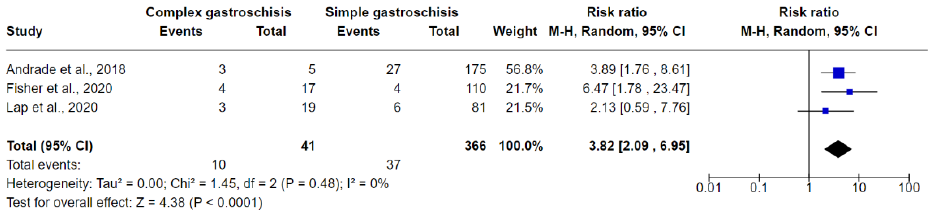
Figure 8. Forest plot between simple and complex gastroschisis for polyhydramnios ultrasound